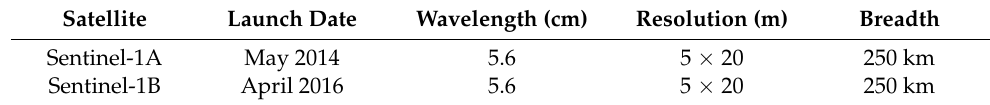
Table 1. Sentinel-1A/1B satellite information.